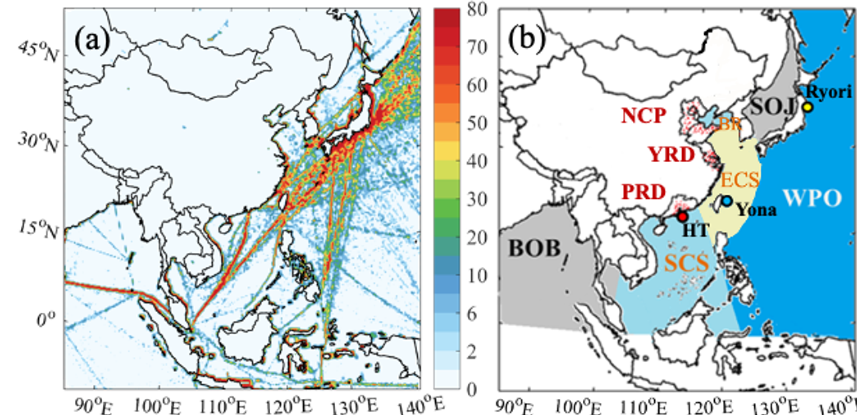
Figure 1. (a) NO x emission fluxes from ships (in gm − 2 month − 1 ) in July 2017. (b) Model domains with six water zones (South China Sea, SCS; East China Sea, ECS; Bohai rim, BR; Sea of Japan, SOJ; Bay of Bengal, BOB; and western Pacific Ocean, WPO), three coastal city clusters (Pearl River Delta, PRD; Yangtze River Delta, YRD; and North China Plain, NCP), and three maritime observational sites (Hok Tsui, HT; Yonagunijima, Yona; and Ryori). Red dots in PRD, YRD, and NCP represent selected coastal sites. The ranges of latitude and longitude in each body of water are listed in Table S1 in the